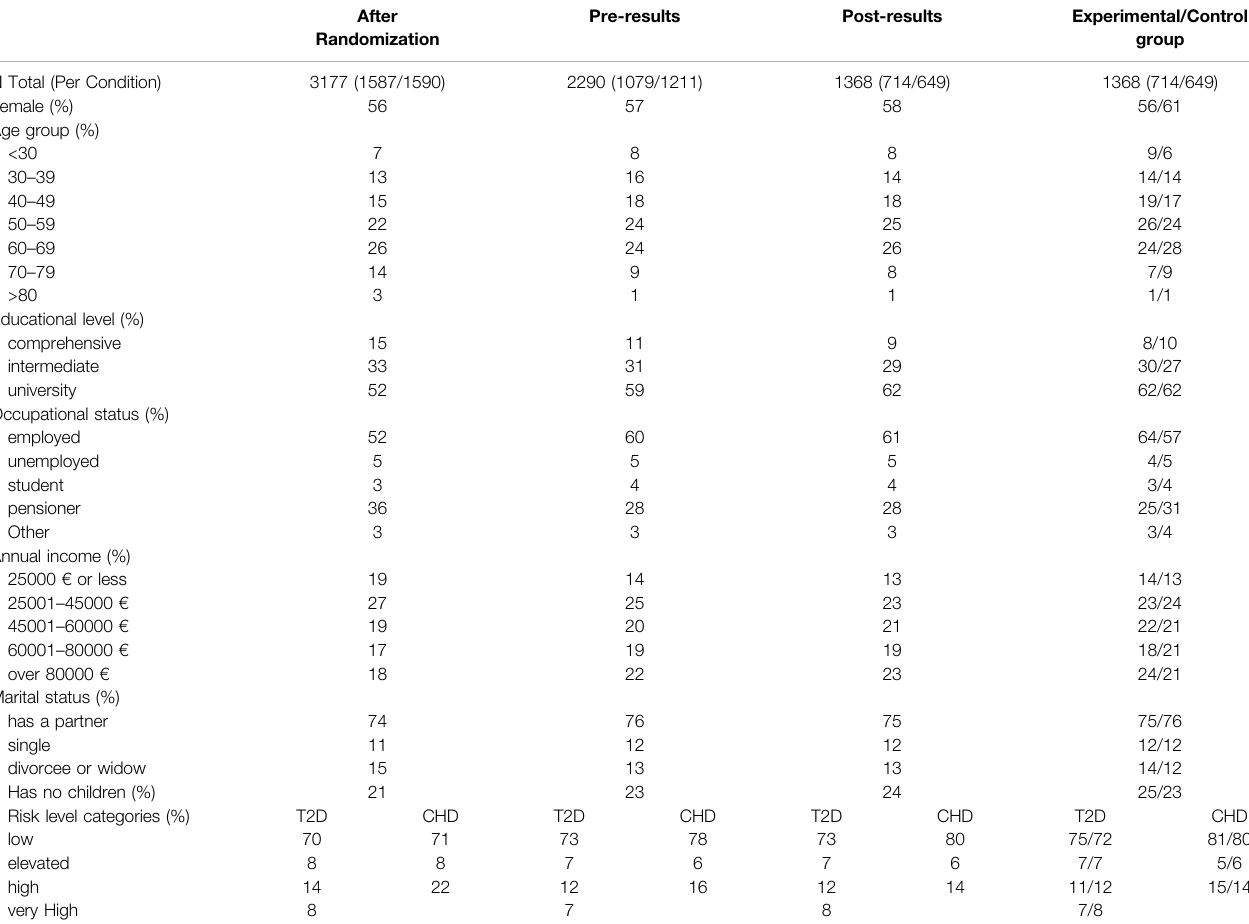
TABLE 1 | Sample descriptives at three time points, and between the experimental and the control group after the post-results survey. After